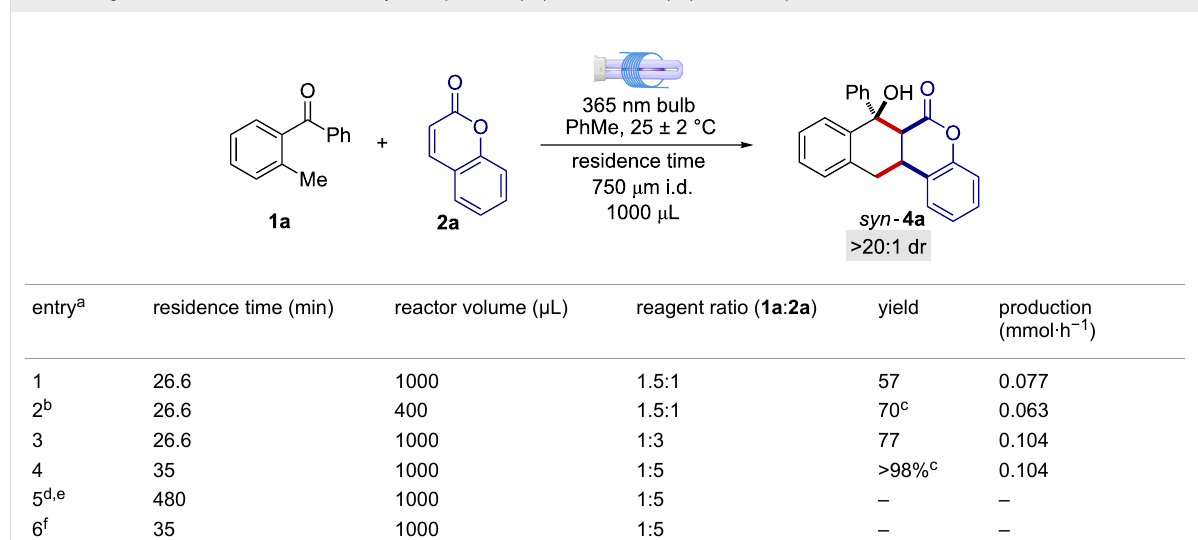
Table 1: Light-driven reaction between 2-methylbenzophenone ( 1a ) and coumarin ( 2a ); selected optimization